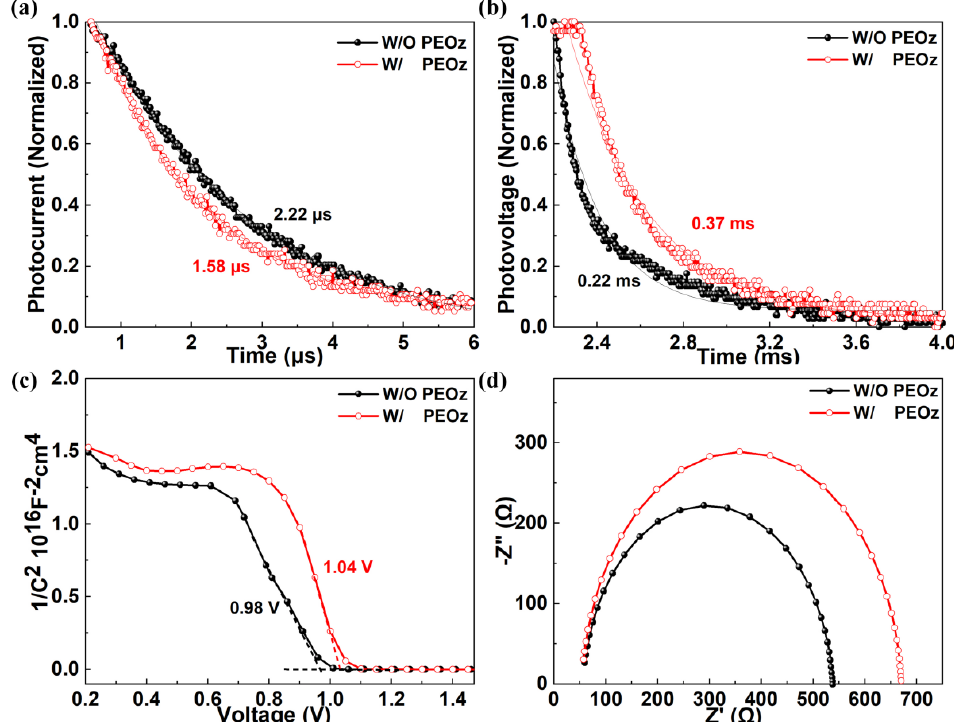
Figure 6. ( a ) TPC, ( b ) TPV and ( c ) M − S measurements of the control PSCs and PEOz − based PSCs. ( d ) The corresponding Nyquist plots measured at a forward bias of 1.2 V dark condition of the control PSCs and PEOz − based PSCs.